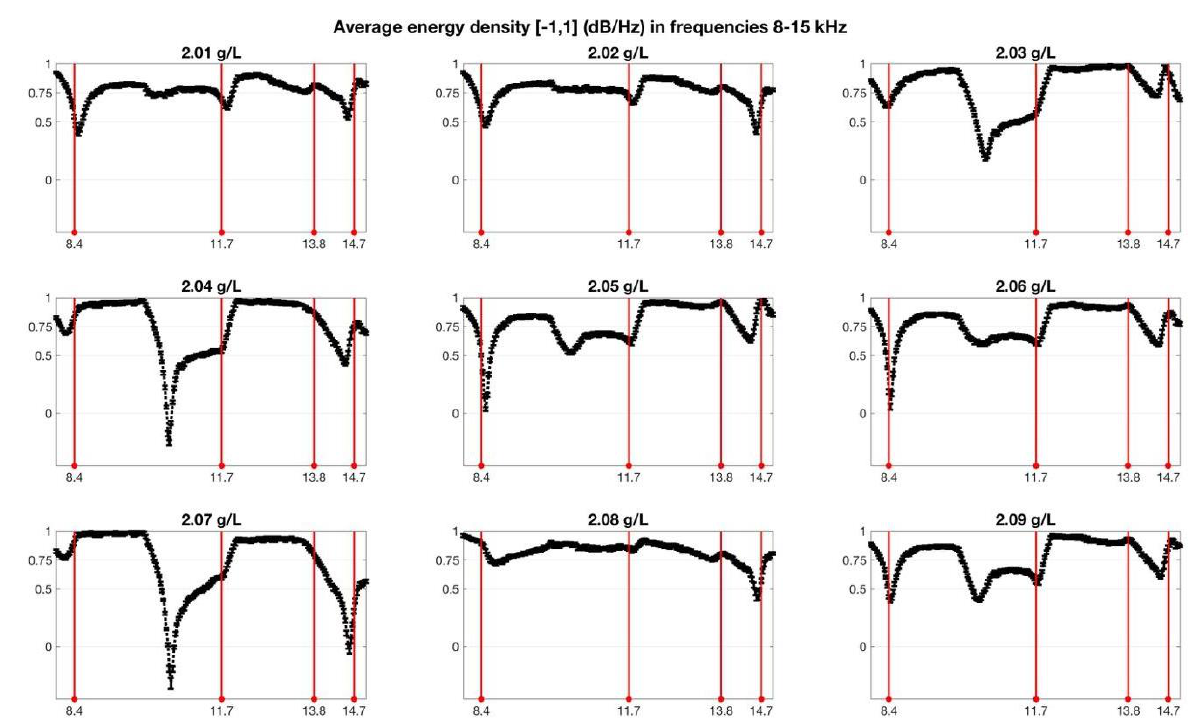
Figure 8. Spectral information of vibrational absorption bands of ten concentrations from 0 g/L to 9 g/L. The curves represent the average and normalized values of the sound pressure level (dB/Hz) over the audible frequencies range. In each spectrum, the frequencies used for both classifiers are emphasized.